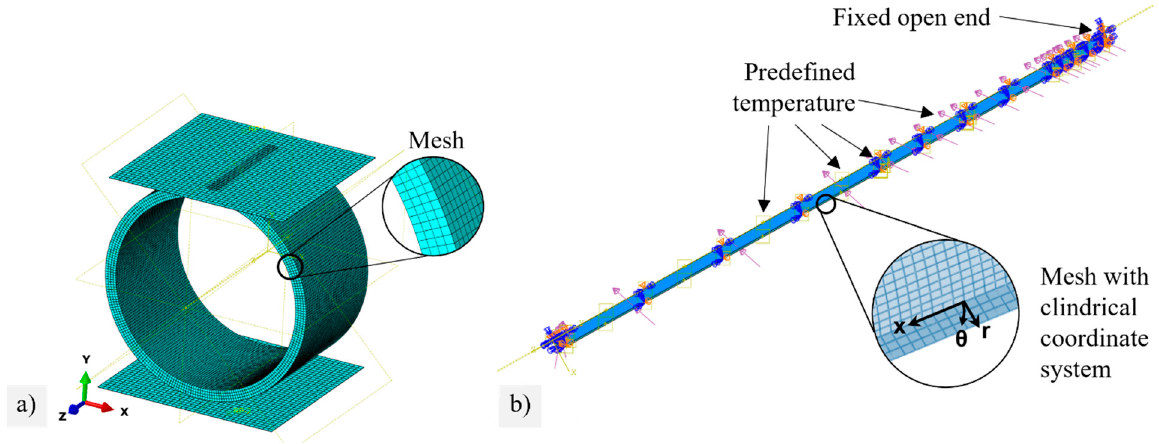
Figure 4. FE model of ( a ) the brittle ring test with structured mesh, ( b ) a membrane tube with boundary conditions and structured mesh in the pilot module.